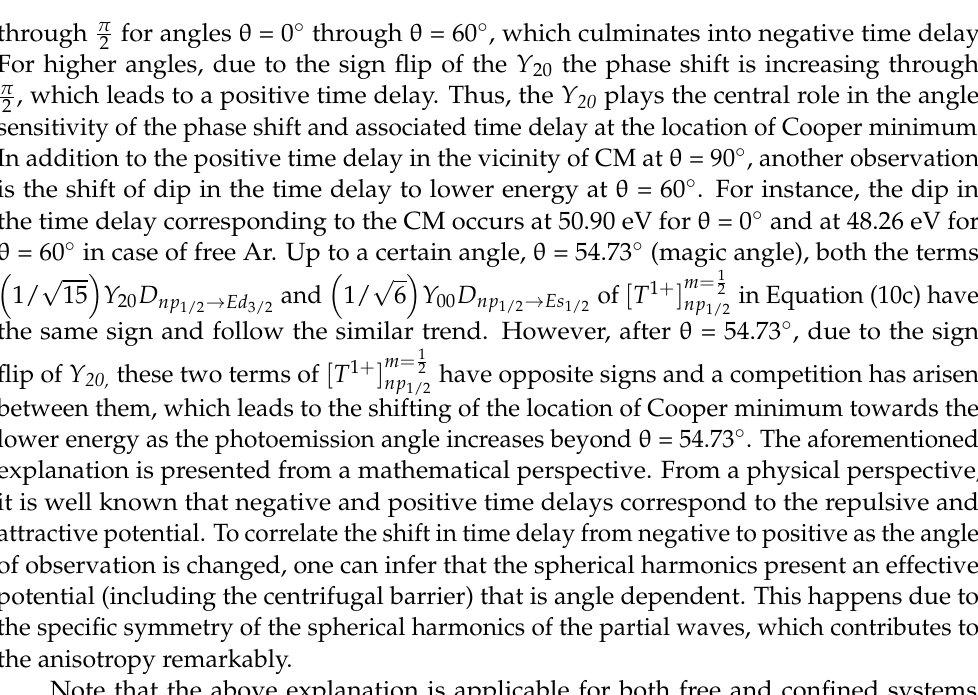
Table 2. The 4p subshell thresholds of free and confined Kr.